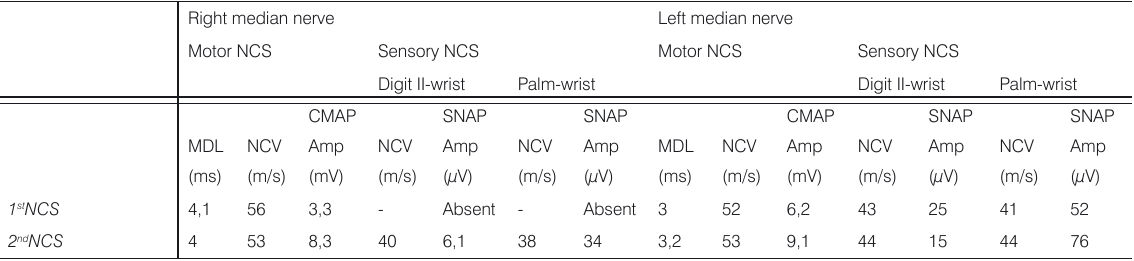
Table 1. The first and second nerve conduction studies (NCS) of right and left median nerves. Note the evident improvement in the compound muscle action potential (CMAP) and sensory nerve action potential (SNAP) of the right median nerve in the second